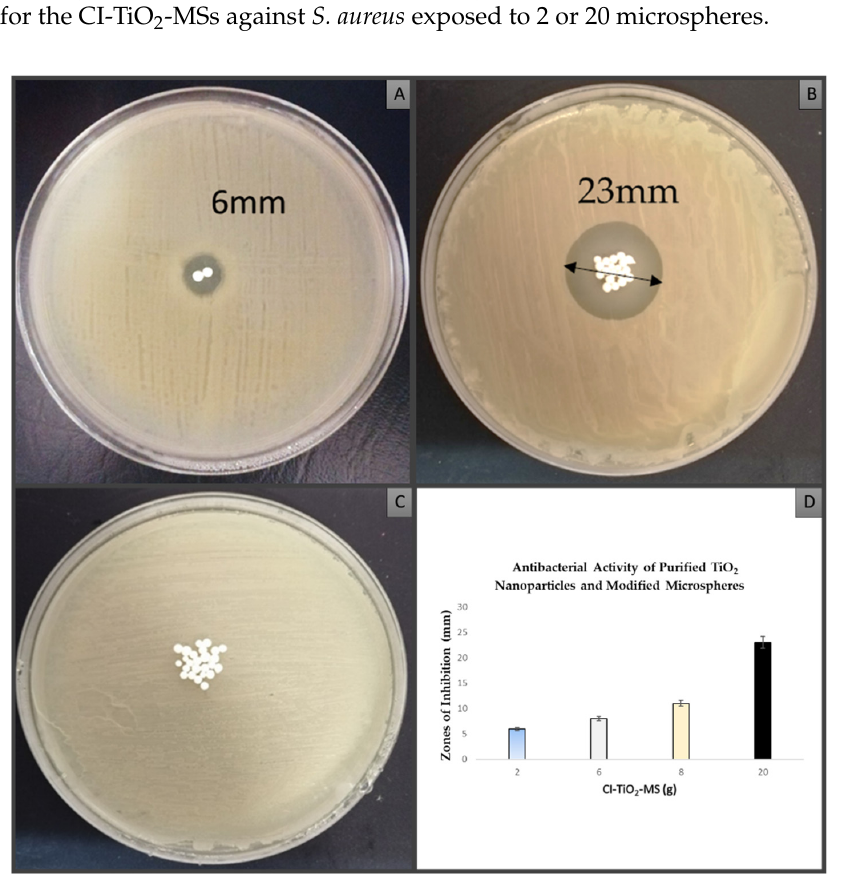
Figure 10. Antibacterial activity of CI-TiO 2 -MSs against S. aureus ; ( A ) 2 MSs ( B ) and 20 MSs. ( C ) Antibacterial activity of TiO 2 -MSs. ( D ) The graph depicts increase in the zone of inhibition by increasing CI-TiO 2 -MS concentration.